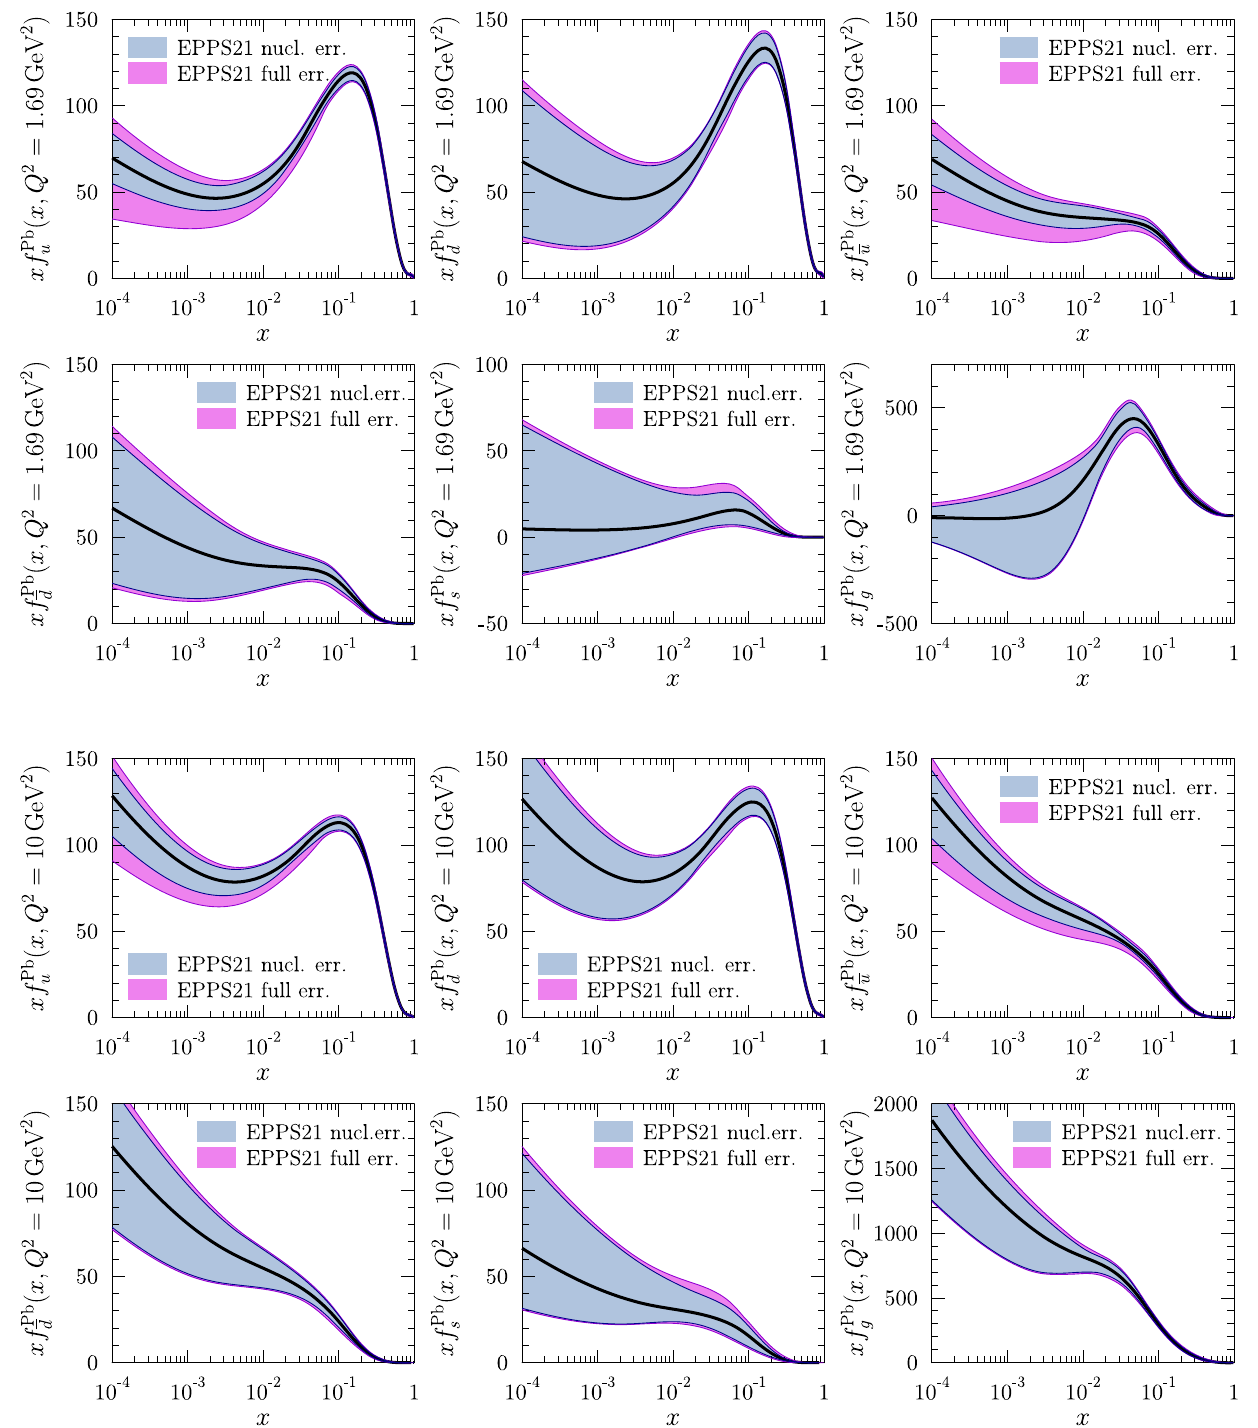
Fig. 11 The 90% confidence-level EPPS21 PDFs in lead nucleus at the parametrization scale Q 2 = 1 . 69GeV 2 (upper panels) and at Q 2 = 10GeV 2 (lower panels). The central results are shown by thick